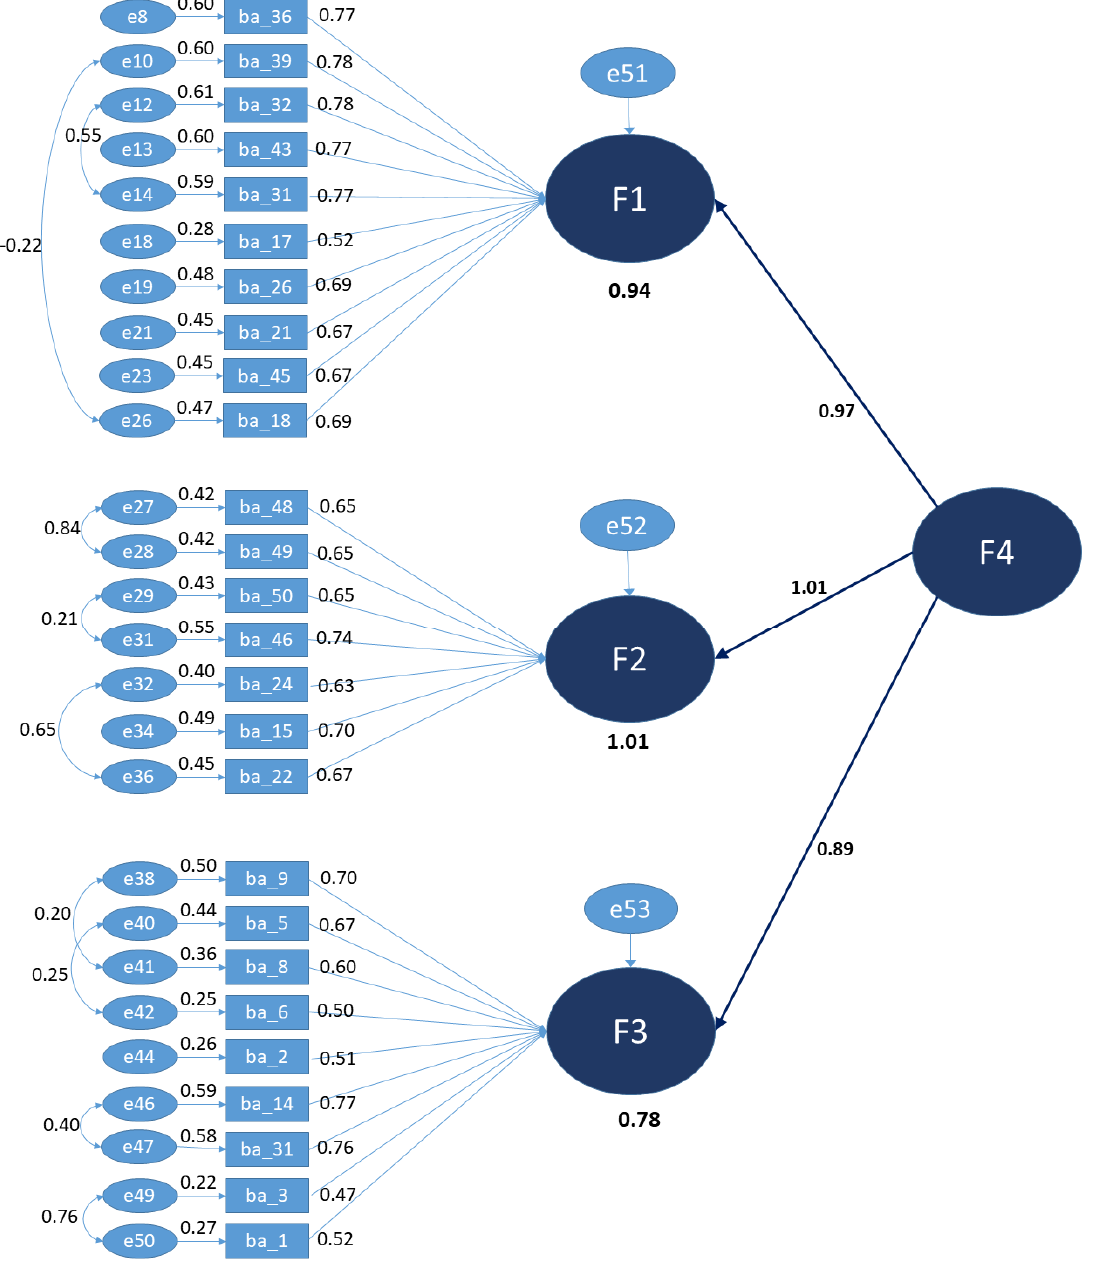
Figure 5. Final second-order model (A high-resolution version is available in the Supplementary Materials—Figure S3).